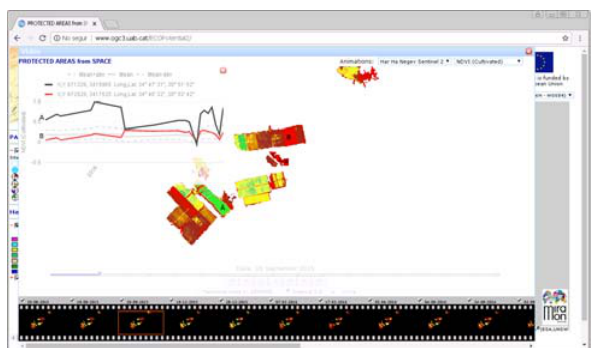
Figure 16. Clicking on particular points, a graphic on the evolution of the NDVI for the whole series can be derived. In this case, the comparison is among points A and